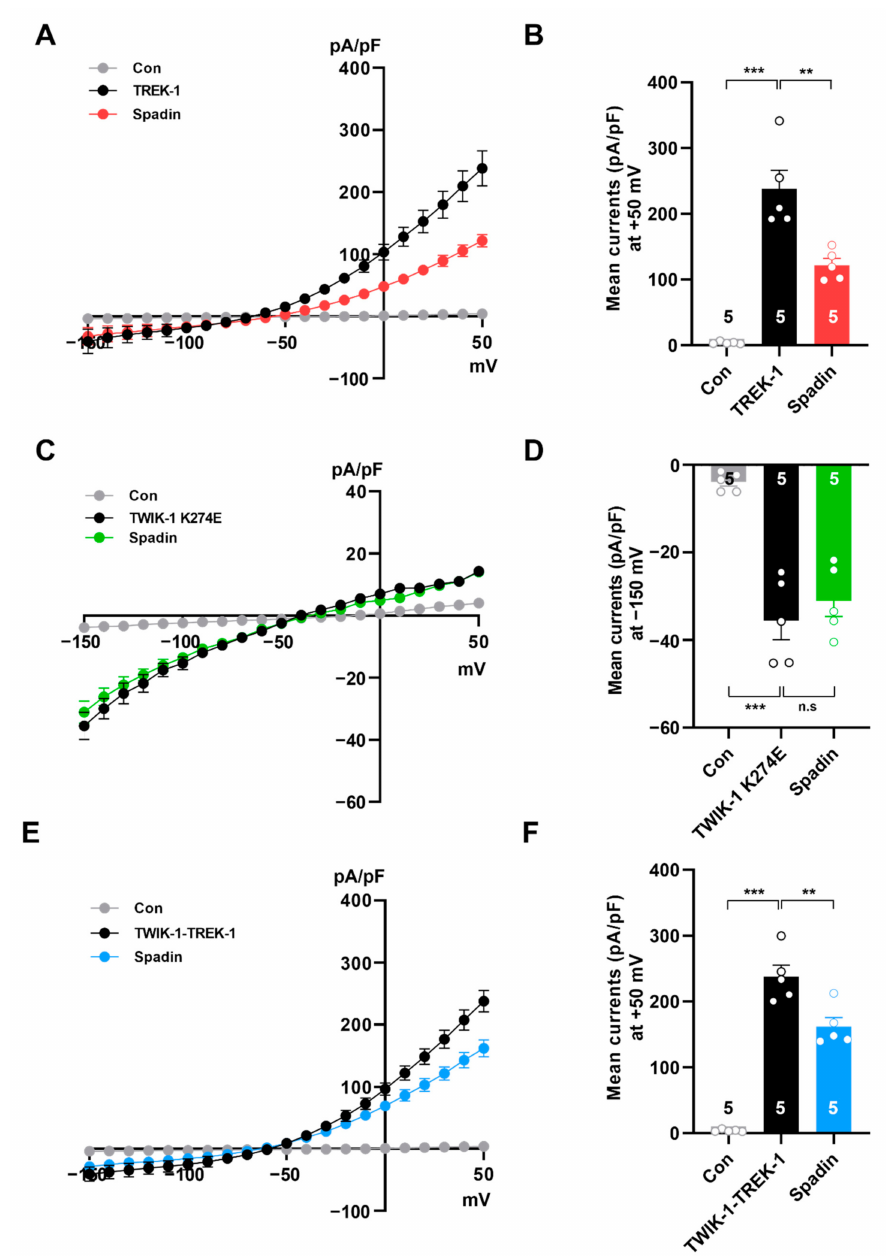
Figure 5. Spadin regulates K + currents mediated by TWIK-1 / TREK-1 heterodimeric channels. Current densities induced by voltage ramping were measured in COS-7 cells transfected with control vector (Con) or several channel expressing vectors. ( A , C , E ) Current densities induced by voltage ramping were measured in COS-7 cells transfected with TREK-1 ( A ), TWIK-1 (K274E) ( C ), and TWIK-1 / TREK-1 ( E ) before and after treatment with 10 µ M spadin, respectively. Summary histograms show averaged current densities recorded from cells expressing TREK-1 ( B ) and TWIK-1 / TREK-1 ( F ) with or without spadin treatment at + 50 mV. The number on each bar indicates n for each condition. ( D ) TWIK-1(K274E)-mediated current densities were averaged from the plots in ( C ) at − 150 mV. The number on each bar indicates n for each condition. All values are mean ± s.e.m. p -values were obtained with one-way ANOVA followed by Turkey’s post hoc test. n.s: not significant, ** p < 0.01 and *** p <